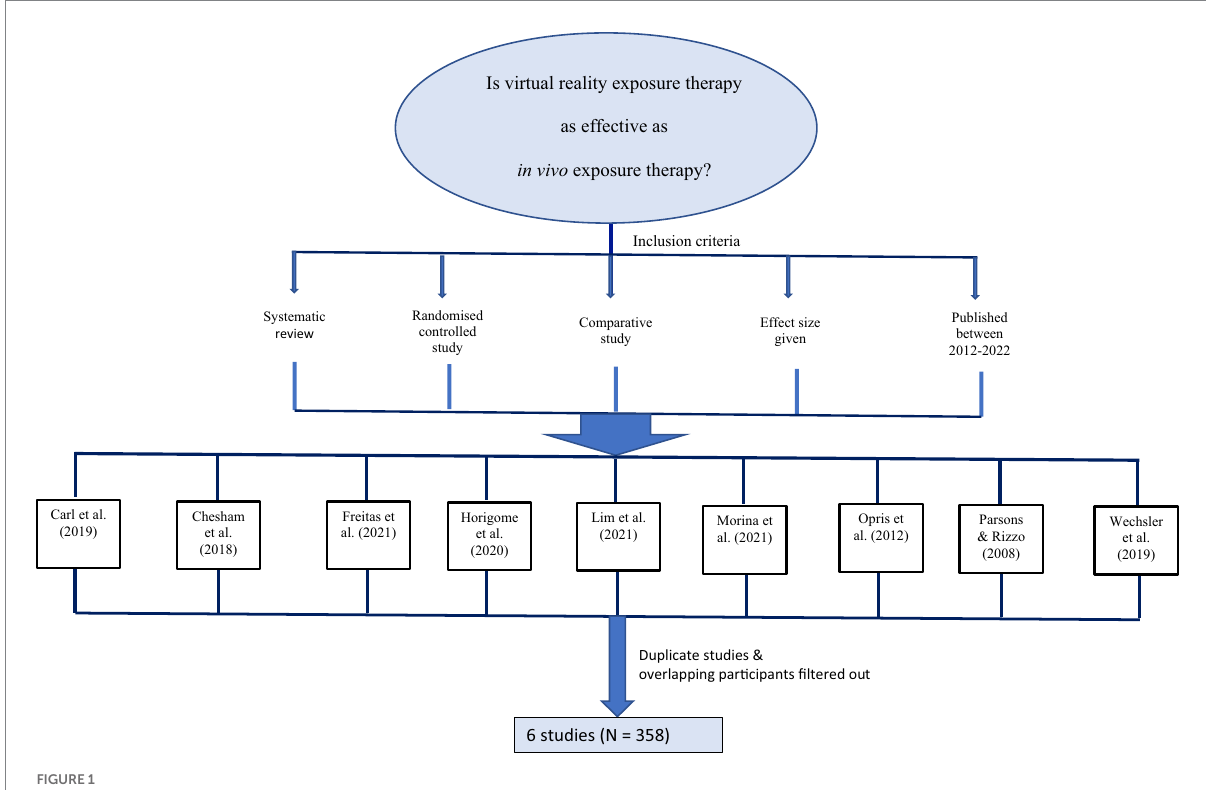
FIGURE 1 Literature selection process for the first research